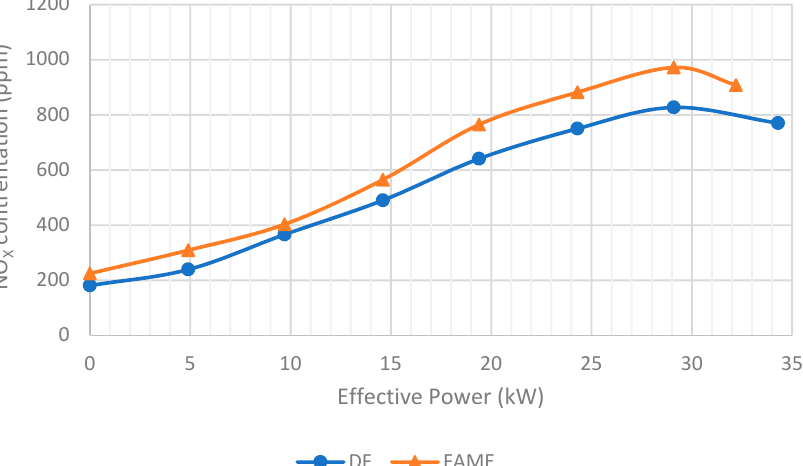
Figure 9. NO x emission level in the exhaust as a function of the effective power of the S-4003 engine, at an engine speed of 2200 rpm.